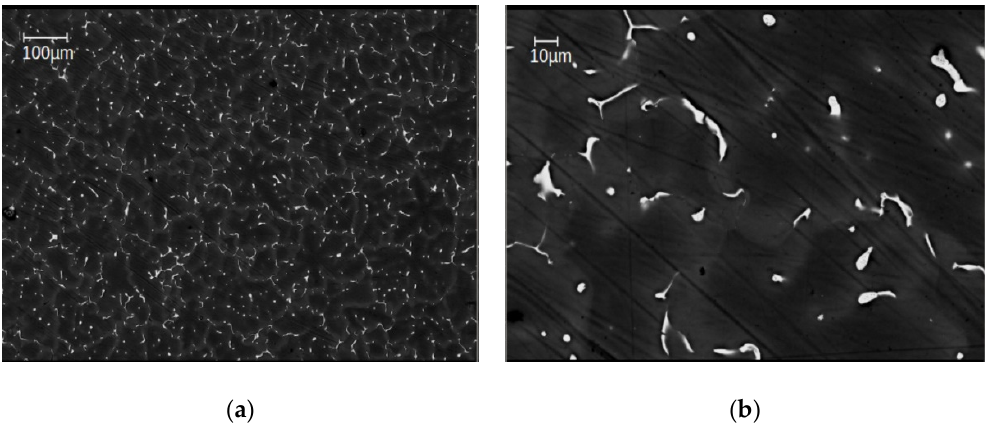
Figure 2. Scanning electron microscope (SEM) images of the as-cast alloy Mg5Zn0.3Ca, with low ( a ) and high ( b ) magnification [15] .